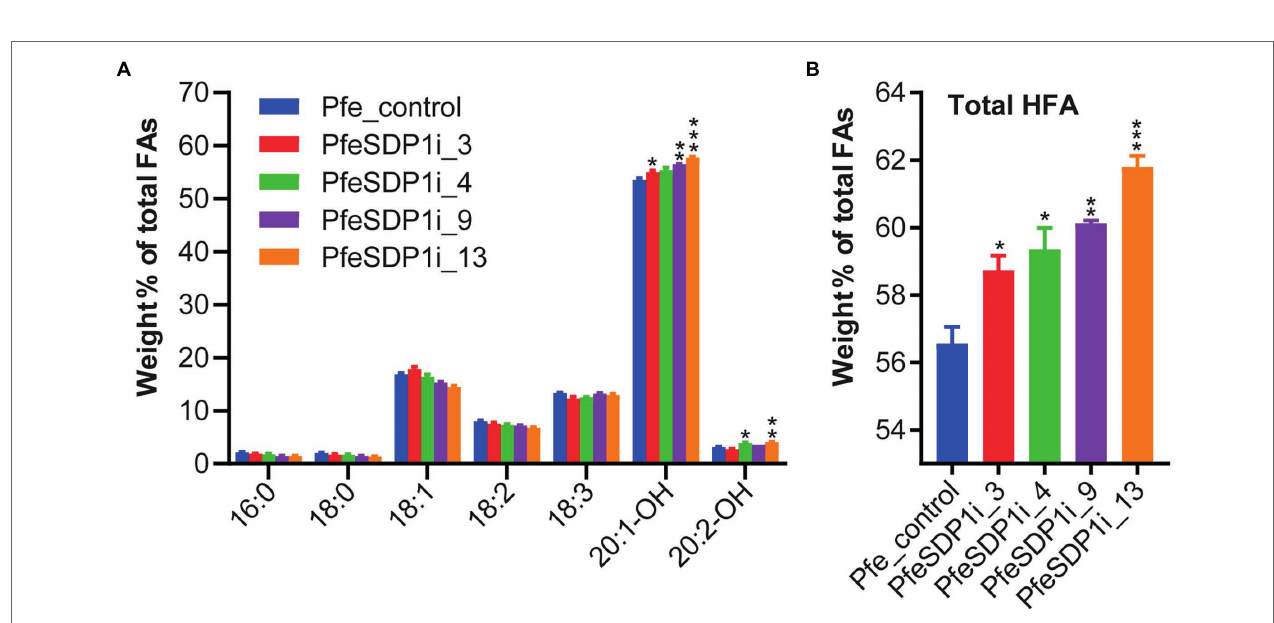
FIGURE 4 | Total fatty acid amount increased in Physaria fendleri SDP1_RNAi seeds. (A) Total fatty acid content of PfeSDP1_RNAi lines, data represents mean ± SEM ( n = 3–10) per line. (B) Individual fatty acid content of lines in (A) . Additional minor fatty acids (18:1-OH, 18:2-OH, 20:0, 20:1) each representing less than 1% of total fatty acids are included in Supplementary Table S2 . Asterisks (*), (**), and (***) indicate significant differences at p < 0.05, p ≤ 0.002, and p ≤ 0.0006 compared to their respective control by two-tailed paired t